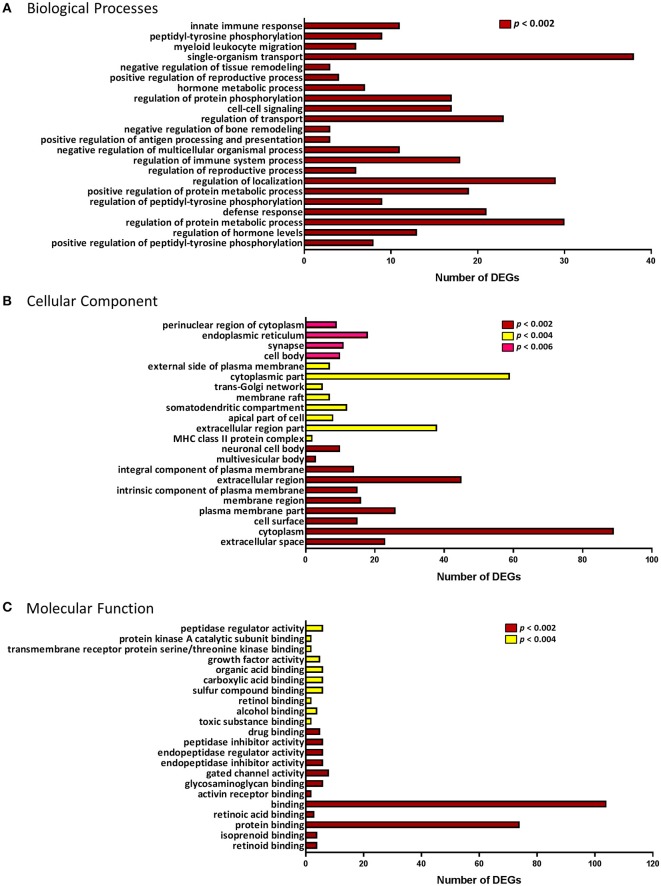
Gene Ontology (GO) enrichment analysis of the differentially expressed genes. GO terminology and the number of differentially expressed genes (DEGs) associated with each of the three categories: (A) Biological processes. (B) Cellular Component. (C) Molecular Function. p-value for over-representation of GO terms in DEGs is represented by: red, p < 0.002; yellow, p < 0.004; and pink, p < 0.006.